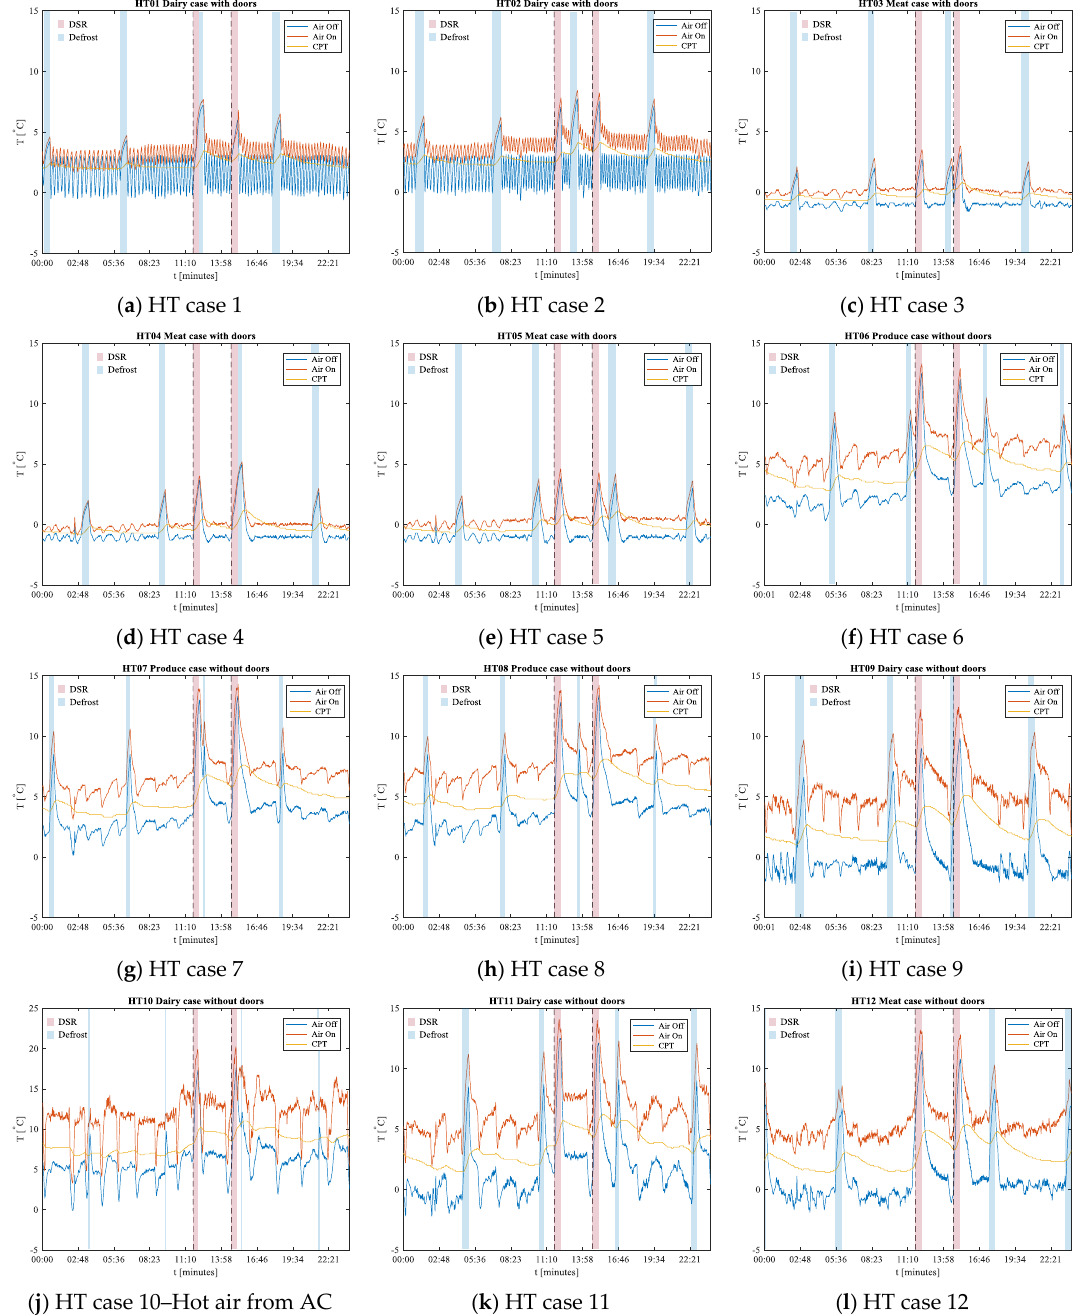
Figure 6. Temperature time histories of HT cases. Two simulated DSR events at 11:45 and 14:45. Cases